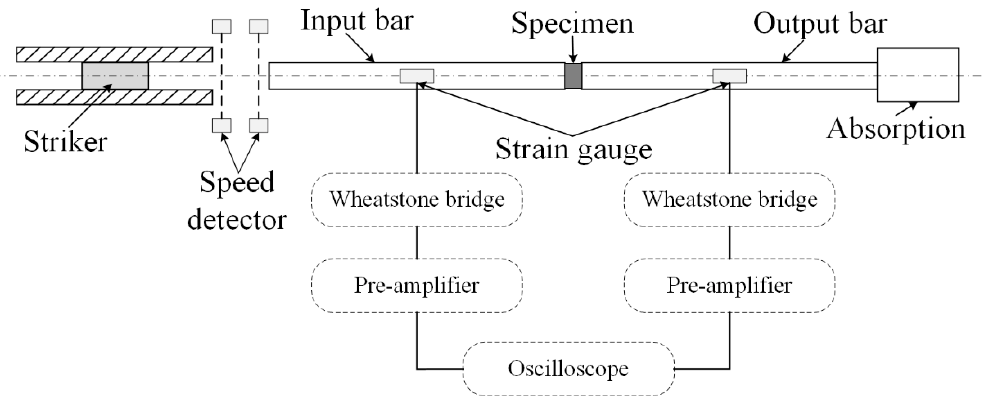
Figure 1. Split Hopkinson Pressure Bar device.